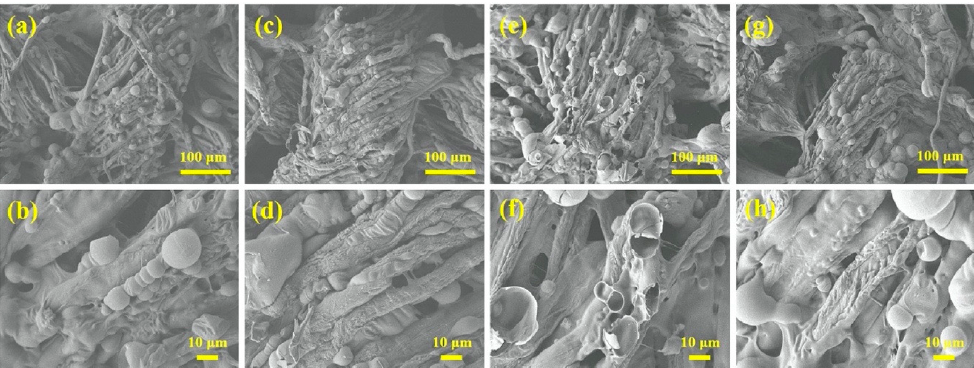
Figure 17. Scanning Electron Microscopy micrographs of the residues after horizontal flame spread tests. C-(PEI / HACH)5 ( a , b ): cotton treated with 5 bi-layers of polyethyleneimine; C-(PEI / HACH)5-crosslink ( c , d ): cotton treated with 5 bi-layers of polyethyleneimine and crosslinked with genipin; C-(PEI / HACH)10 ( e , f ): cotton treated with 10 bi-layers of polyethyleneimine; C-(PEI / HACH)10-crosslink ( g , h ): cotton treated with 10 bi-layers of polyethyleneimine and crosslinked with genipin. Reprinted with permission from [48]. Copyright 2019, Elsevier.